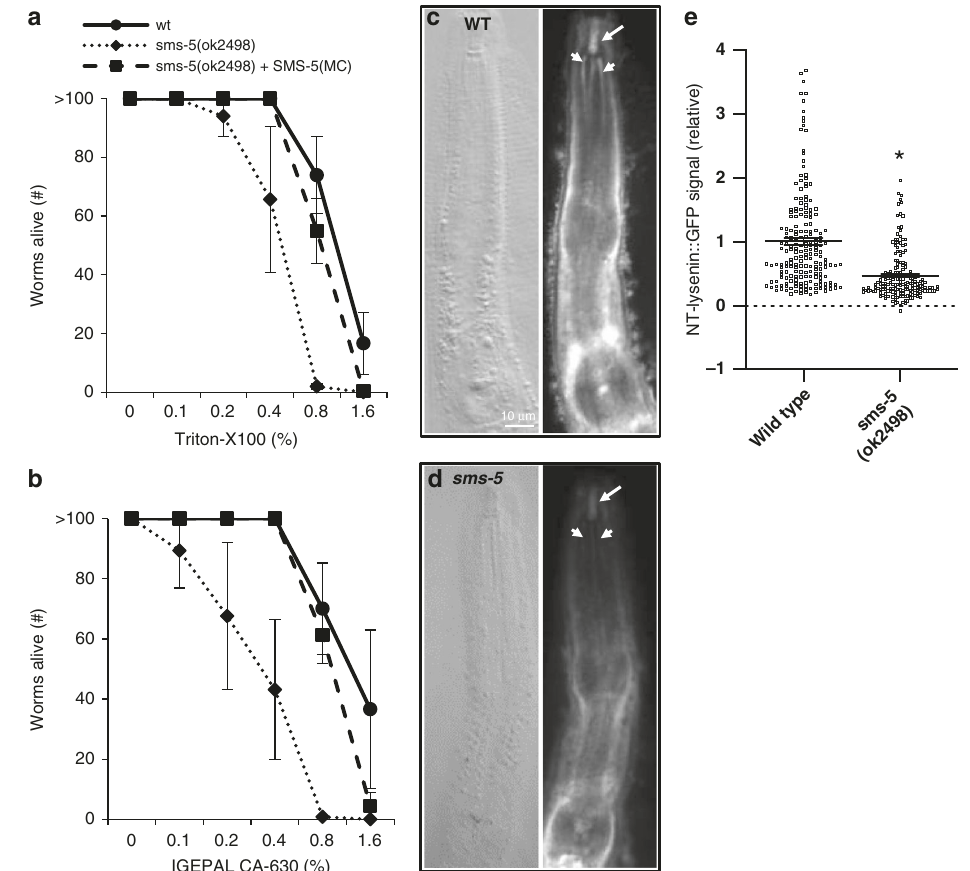
Fig. 6 sms-5 mutants have less sphingomyelin in the anterior pharynx. a , b The sms-5 deletion allele is hypersensitive to the lethality induced by detergents triton-X 100 and IGEPAL CA-630, shown as a v/v percentage of the liquid media. In both cases, differences are signi fi cant ( p < 0.05) at a detergent concentration of 0.8% (w/v) using a Student ’ s T test. SMS-5(MC) represents marginal-cell-speci fi c expression of SMS-5::FLAG::mCherry from the trIs104 integrated transgenic array. Three biological repeats were done with four technical repeats done during each biological repeat. c , d Wild-type and sms-5 (ok2498) mutant animals are fi xed and stained with the GFP-NT-Lysenin protein probe that recognizes clustered sphingomyelin. White arrows indicate buccal cavity and white arrowheads indicate anterior channels. For each pair of images, the differential interference contrast image is on the left, and the fl uorescent image is on the right. The scale is the same for all panels. e Quanti fi cation of the relative green fl uorescent protein (GFP) signal from more than fi ve biological replicates of GFP-NT-Lysenin staining (see “ Methods ” for details). Asterisk (*) indicates a signi fi cant difference ( p = 0.024) using a Student ’ s T test. n = 7 independent trials with at least 10 worms analyzed during each trial. Error bars represent standard error of the mean (SEM) for all graphs in this fi gure. Source data for a , b , and e are provided in the Source Data fi